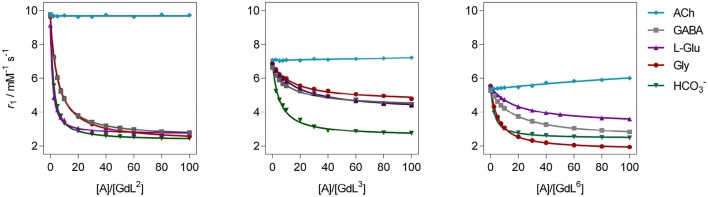
1H longitudinal relaxometric titration curves for GdL2, 3, 6 with different analytes A ([GdL2, 3] = 3.0 mM or [GdL6] = 1.0 mM, 298 K, pH 7.4, 50 mM HEPES, B0 = 7.05 T). The lines represent the fits as explained in the text.